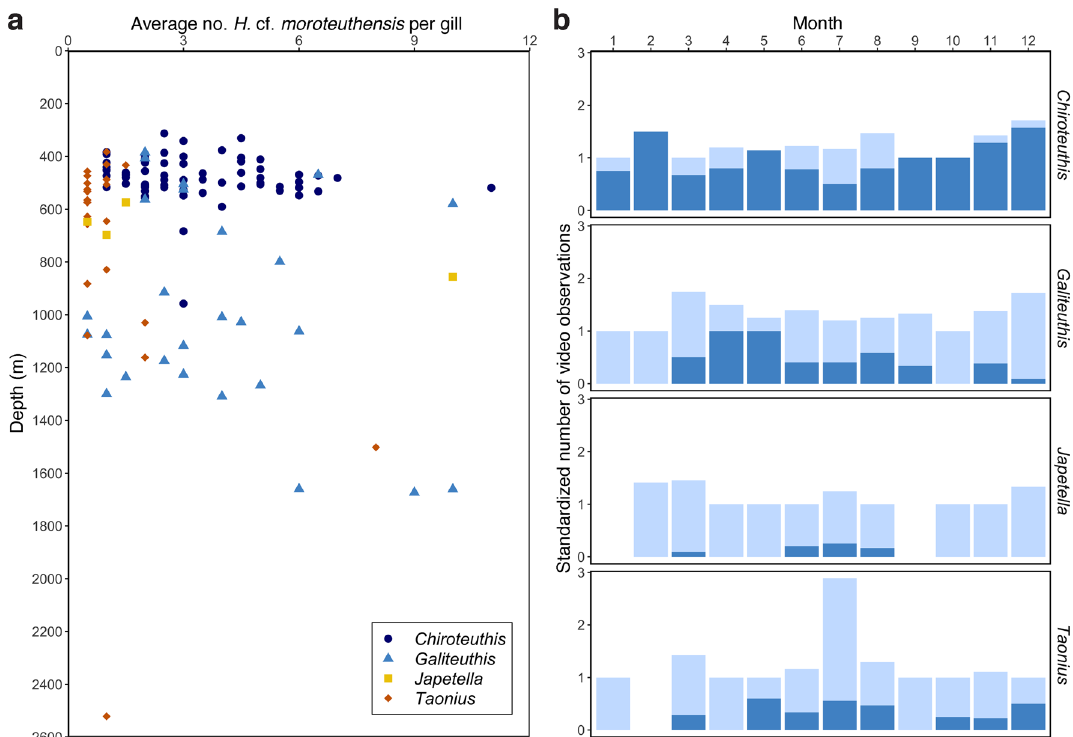
Figure 5. Infection intensity of Hochbergia cf. moroteuthensis by depth and month. ( a ) Average number of Hochbergia per gill per depth for Chiroteuthis (blue circle), Galiteuthis. (light blue triangle), Taonius (orange diamond) and Japetella (yellow square). ( b ) Number of cephalopod sightings per month (light blue) parasitized by Hochbergia (dark blue). Monthly values are corrected for the total number of ROV dives each month, pooling all recorded years. The numbers 1 to 12 represent the months January to December. Blank entries indicate no host sightings in these months despite dive